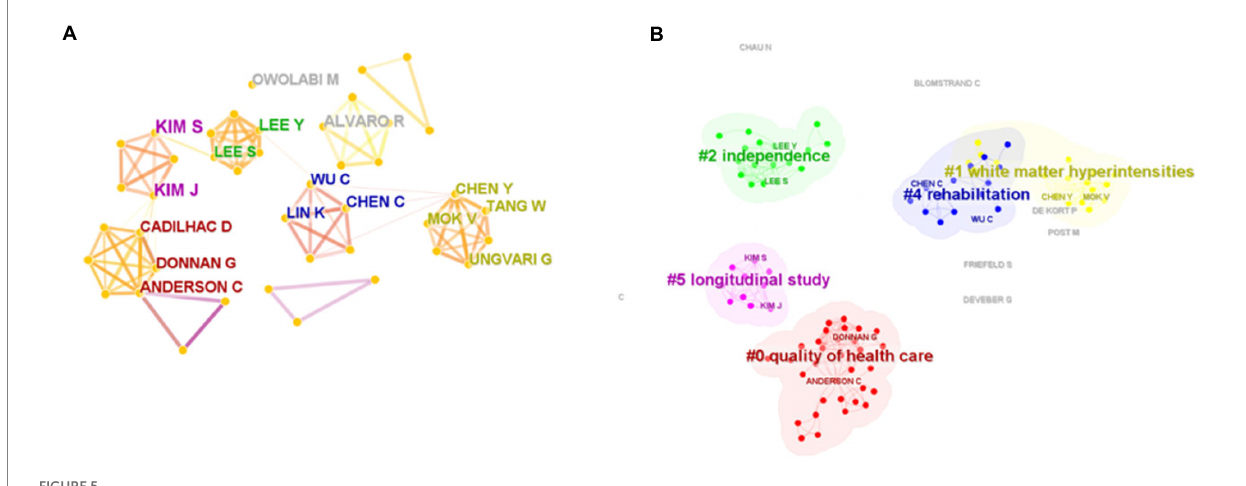
FIGURE 5 (A) Map of authors with publications. (B) Map of clustering of authors.